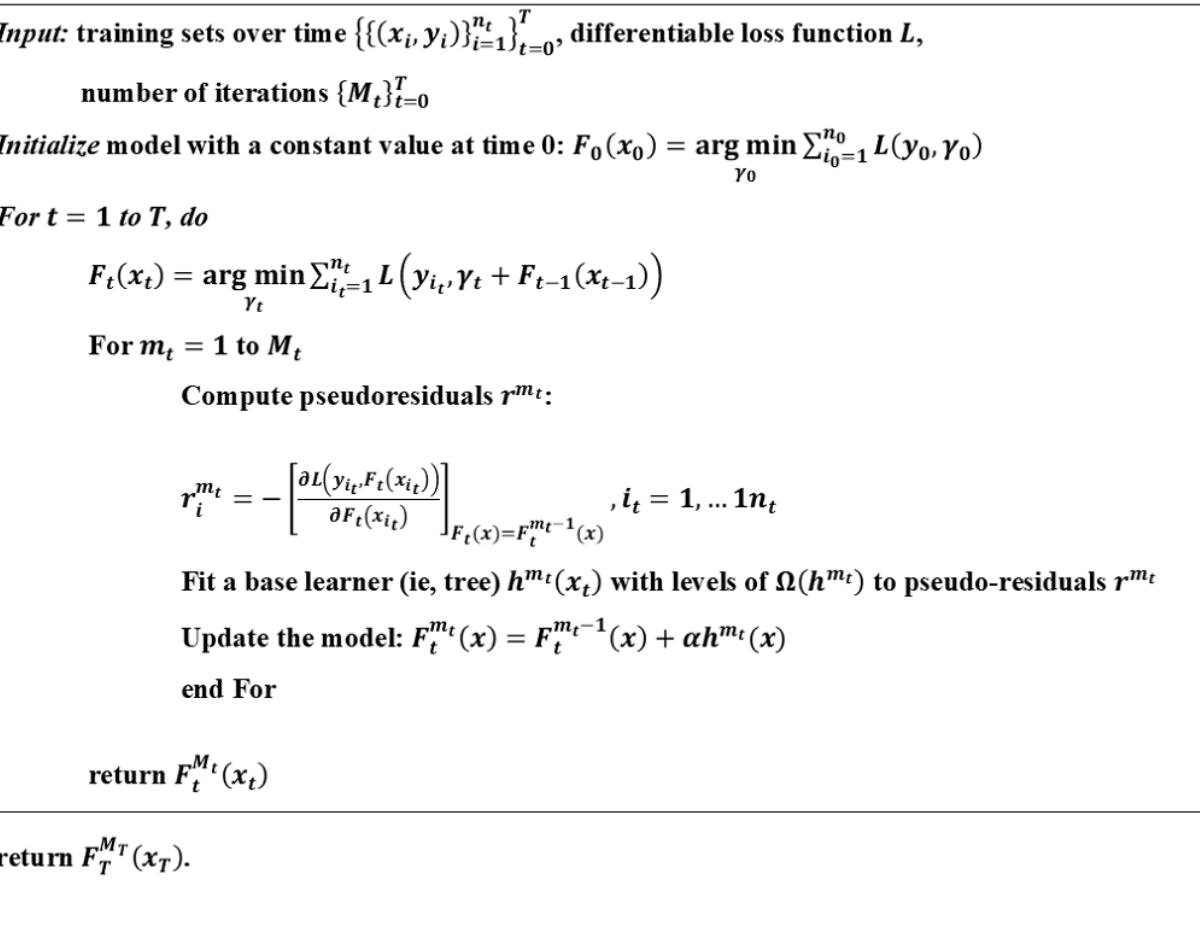
Figure 4. Pseudocode for landmark boosting algorithm. In this experiment, Mt (the number of trees at each iteration is set to 1000), α (learning rate), and Ω (hMt) (levels of each tree) are hyperparameters tuned by 10-fold cross-validation on the training dataset at each iteration.